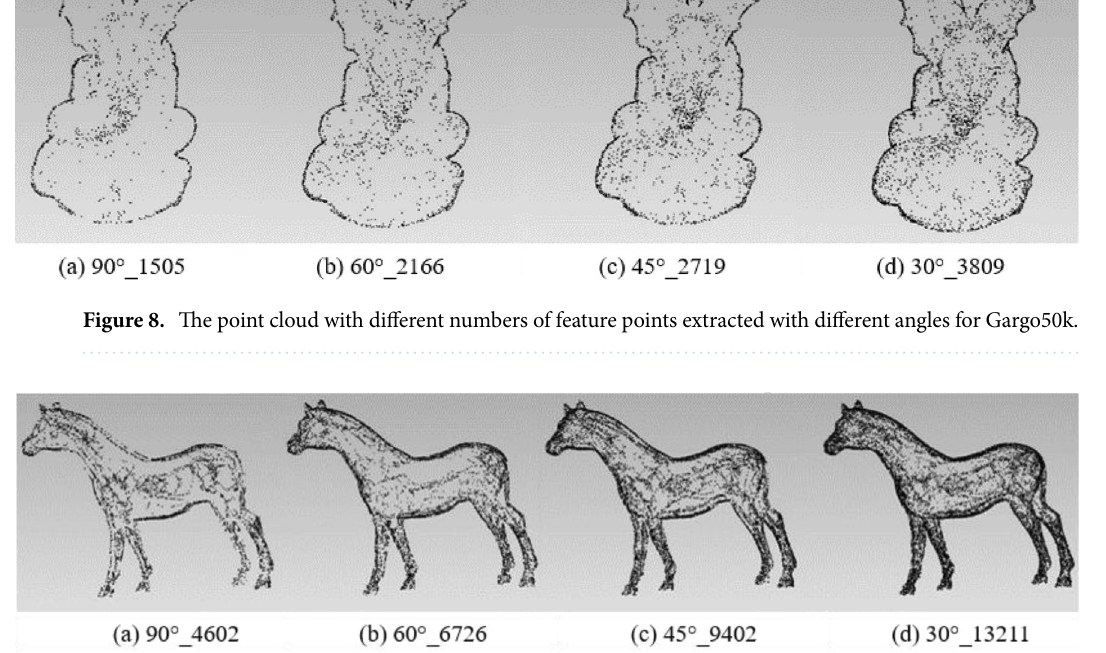
Figure 9. The point cloud with different numbers of feature points extracted with different angles for